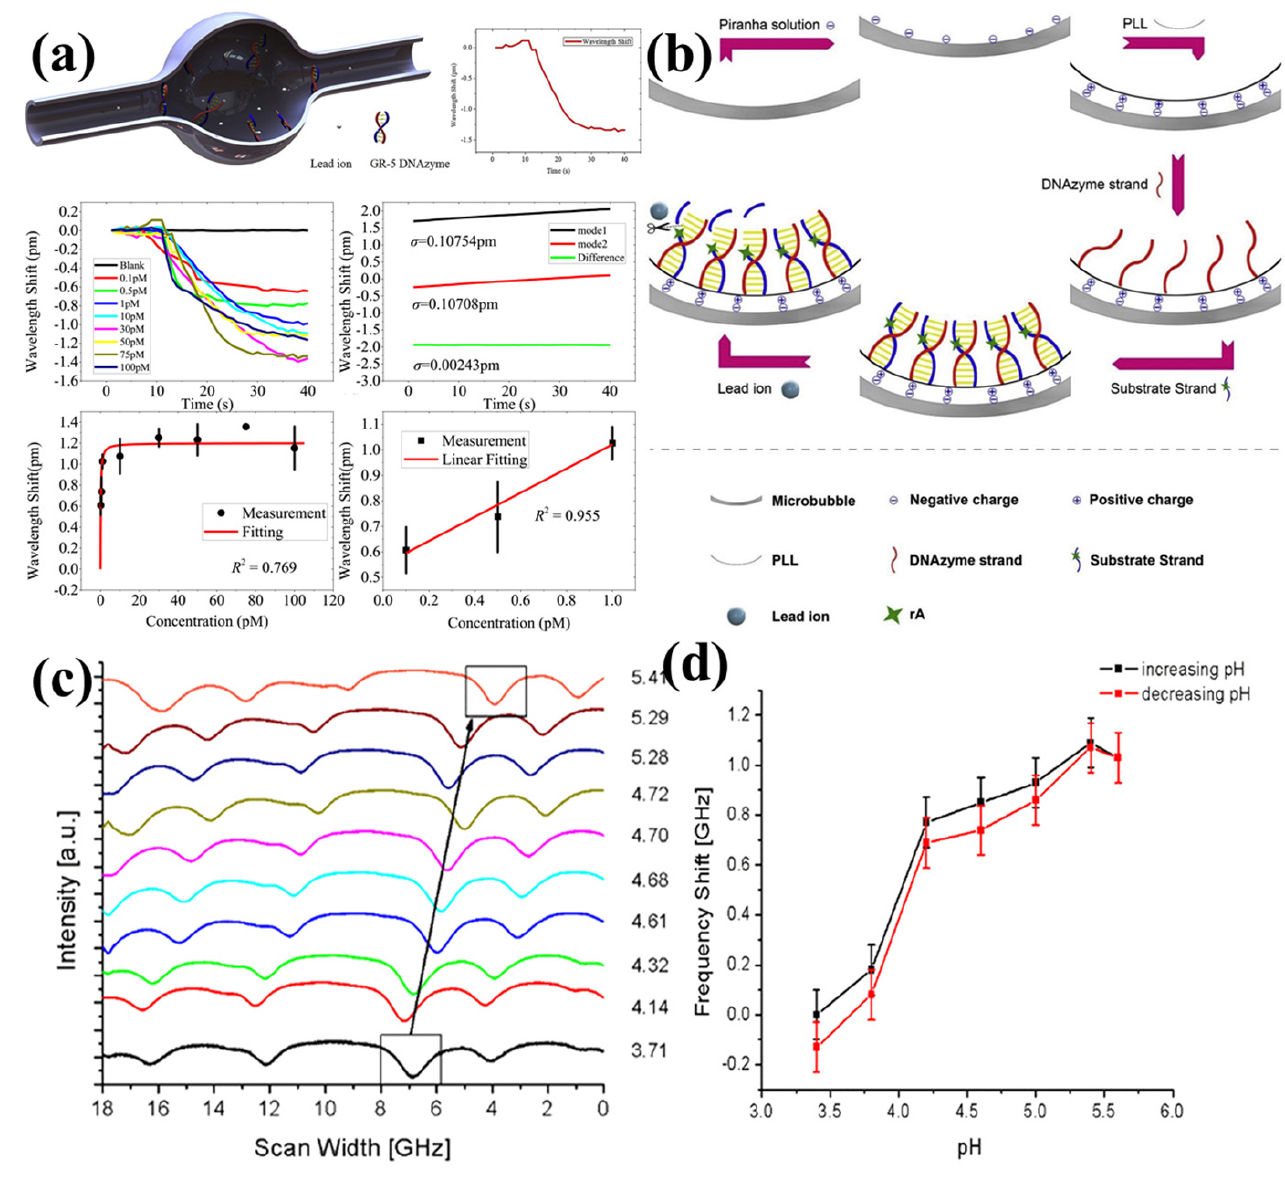
Figure 12. Sensing of ( a , b ) lead-ions concentrations with the microbubble resonators (reprinted with permission from [125], © Elsevier) and ( c , d ) pH values with the microbubble resonators (reprinted with permission from [126], © Elsevier).